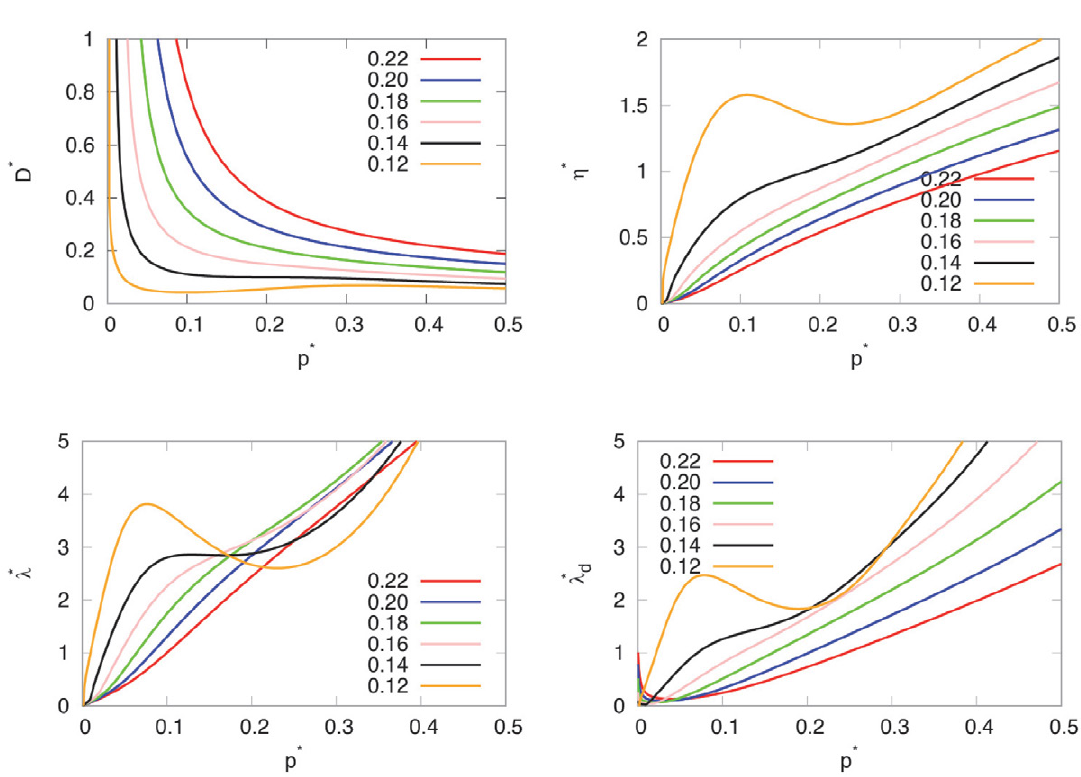
Figure 10: Pressure dependence of the diffusion ( D * ), viscosity ( h * ), thermal conductivity ( l * ) and thermal diffusivity ( l d* ) for 2D MB water for different temperatures calculated by the